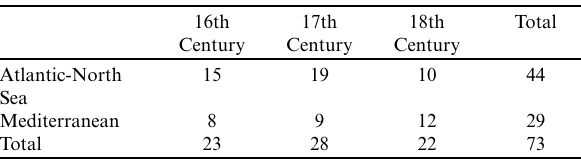
Table 1 . Number of paintings by period and